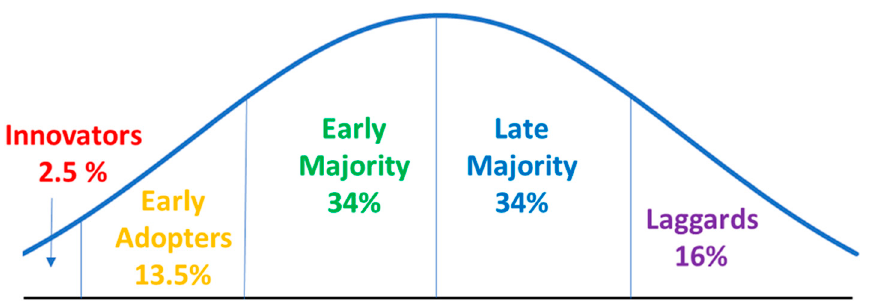
Figure 2. Stages of adoption of an innovation, according to Roger’s classical diffusion of innovation theory [66].